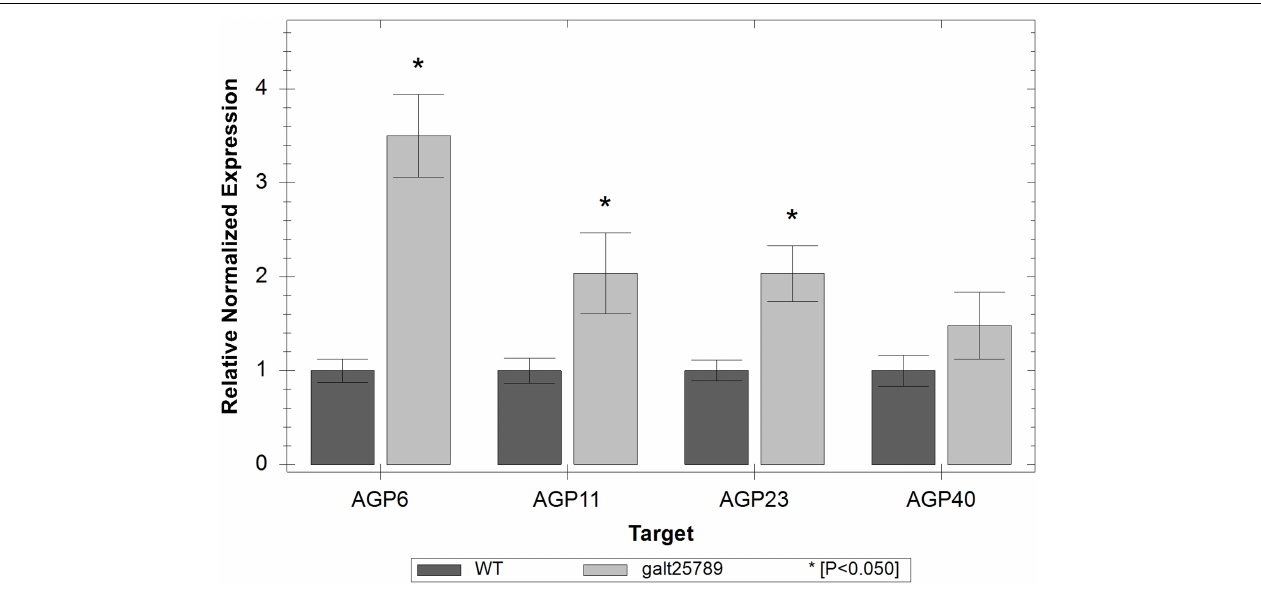
FIGURE 9 | Real time RT-PCR showing relative expression of pollen-specific AGP genes ( AGP6, AGP11, AGP23, and AGP40 ) in galt25789 mutants compared to their expression in WT inflorescences. The level of the transcripts was normalized according to the reference genes ACT8 and RUB1 . Each bar represents an average of the three technical replicas; the * represents a significant result for p <